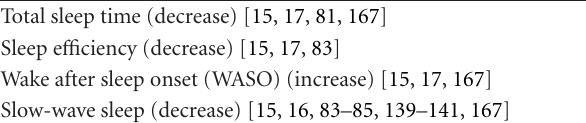
Table 1: Consistent sleep changes reported from young to older